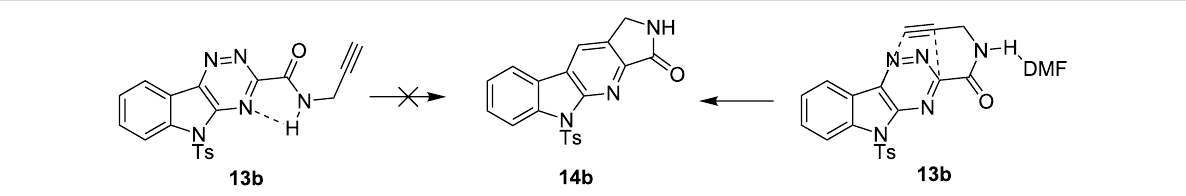
Scheme 7: Intramolecular hydrogen bonding prevents IEDDA cycloaddition of 14b .